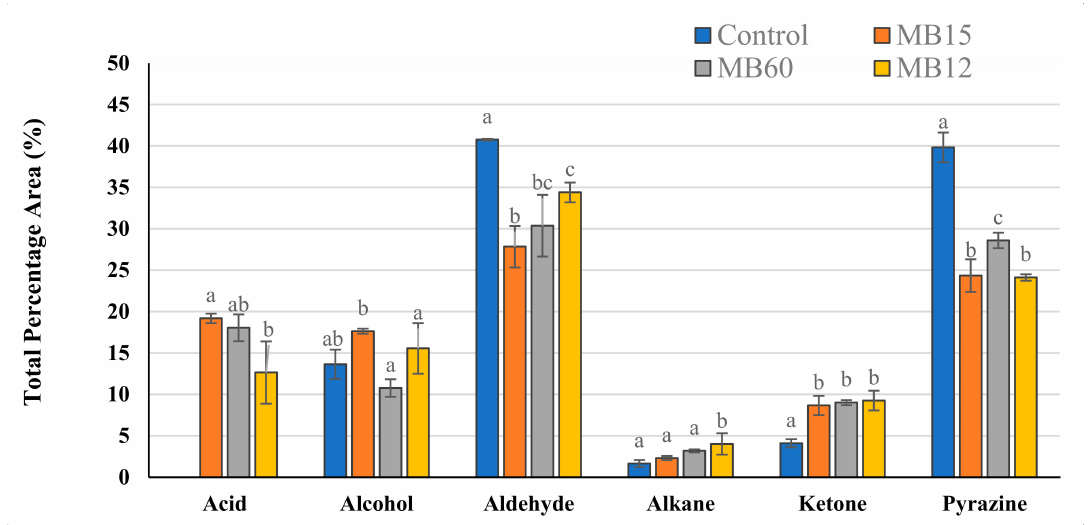
Figure 3. Total percentage area (%) of the chemical classes identified in the volatile fraction of the Meat Broth formulated with 10% of lyophilized pork loin and fermented by P. pentosaceus C12 (MB12), P. pentosaceus C15 (MB15), and L. plantarum C60 (MB60). Different letters represent statistical differences in the same group of molecules between treatments ( p ≤